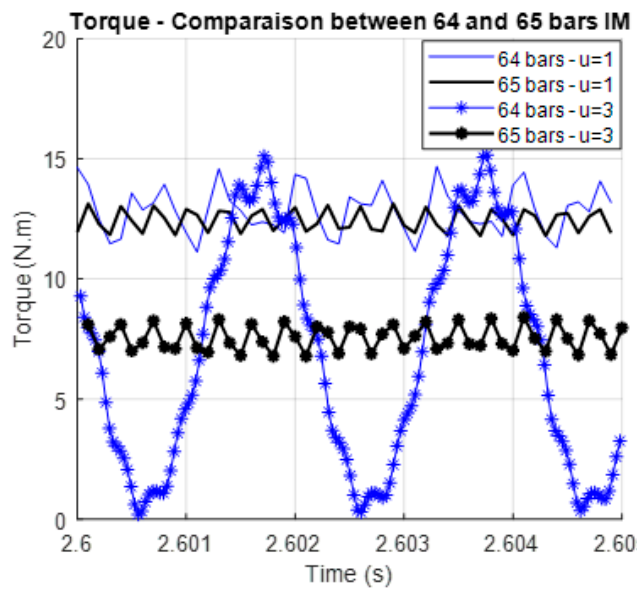
Figure 11. Comparison of the developed torque with 64 and 65 bars, five-phase